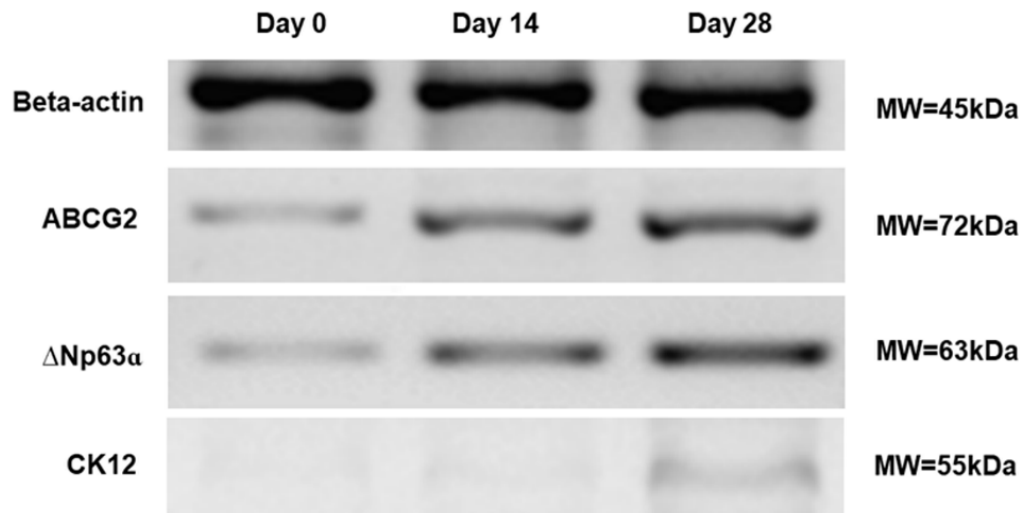
Figure 4. Western blot analysis during the differentiation of human iPS cells into limbal progenitor cells with the optimal BMP4 treatment. The expression levels of ABCG2 and ∆ Np63 α (limbal progenitor cell markers) and CK12 (corne-al epithelial cell marker) increased over time. β -actin was used as a reference protein. Representative figures from three independent experiments are shown.